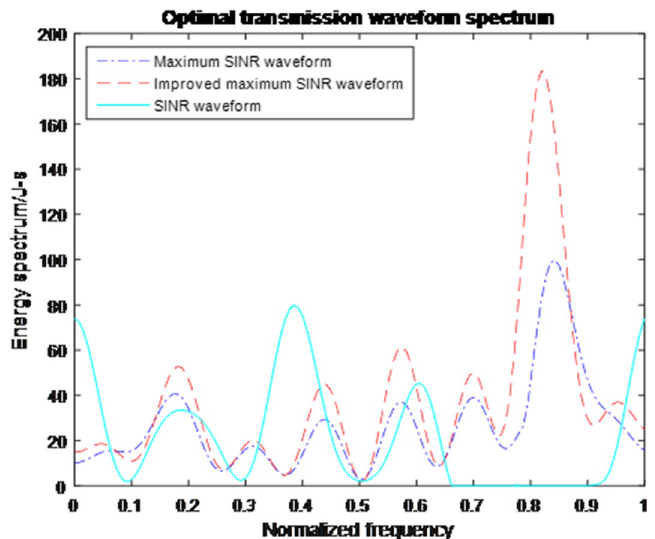
Fig. 10 Transmission waveform spectrum of radar with minmax